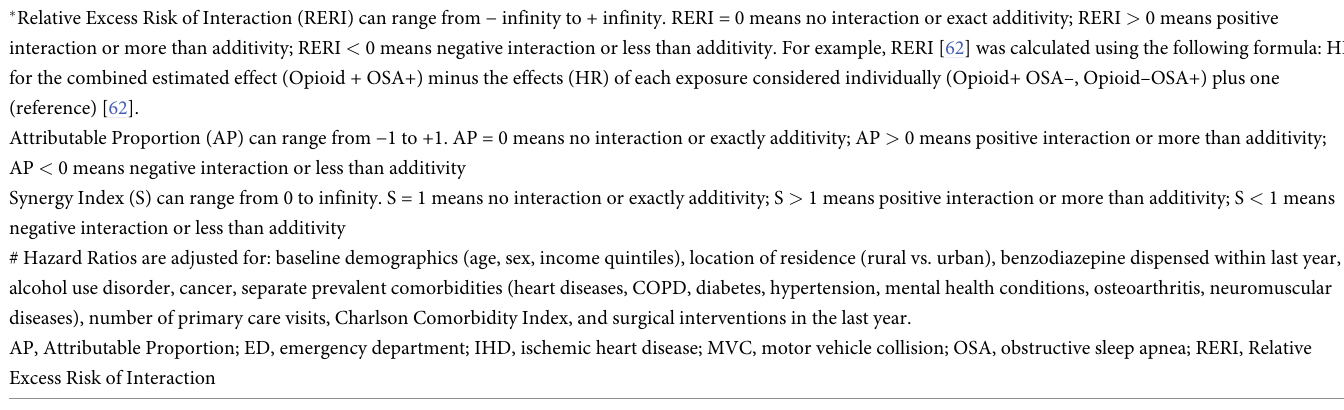
Details on the effect of other covariates are presented in S2 Table . Controlling for other covariates, living in lower neighbourhood income or rural area, alcohol use disorder/intoxica- tion, neuromuscular disease, and prevalent coronary artery disease were significantly associ- ated with all outcomes of interest. Benzodiazepine use at any time in the last year prior to the index date and higher Charlson Comorbidity Index were both significantly associated with all-